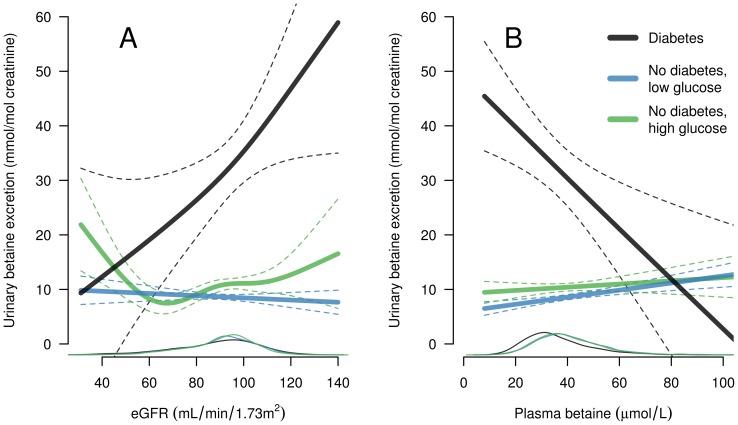
Generalized linear models showing age and gender adjusted associations between urinary betaine excretion and estimated glomerular filtration rate (A) and plasma betaine (B).Results, with 95% confidence intervals, for patients with diabetes mellitus (black line), no diabetes and serum glucose ≥5.5 mmol/L (green line), and no diabetes and serum glucose <5.5 mmol/L (blue line) are shown. Lines at the bottom indicate distribution.